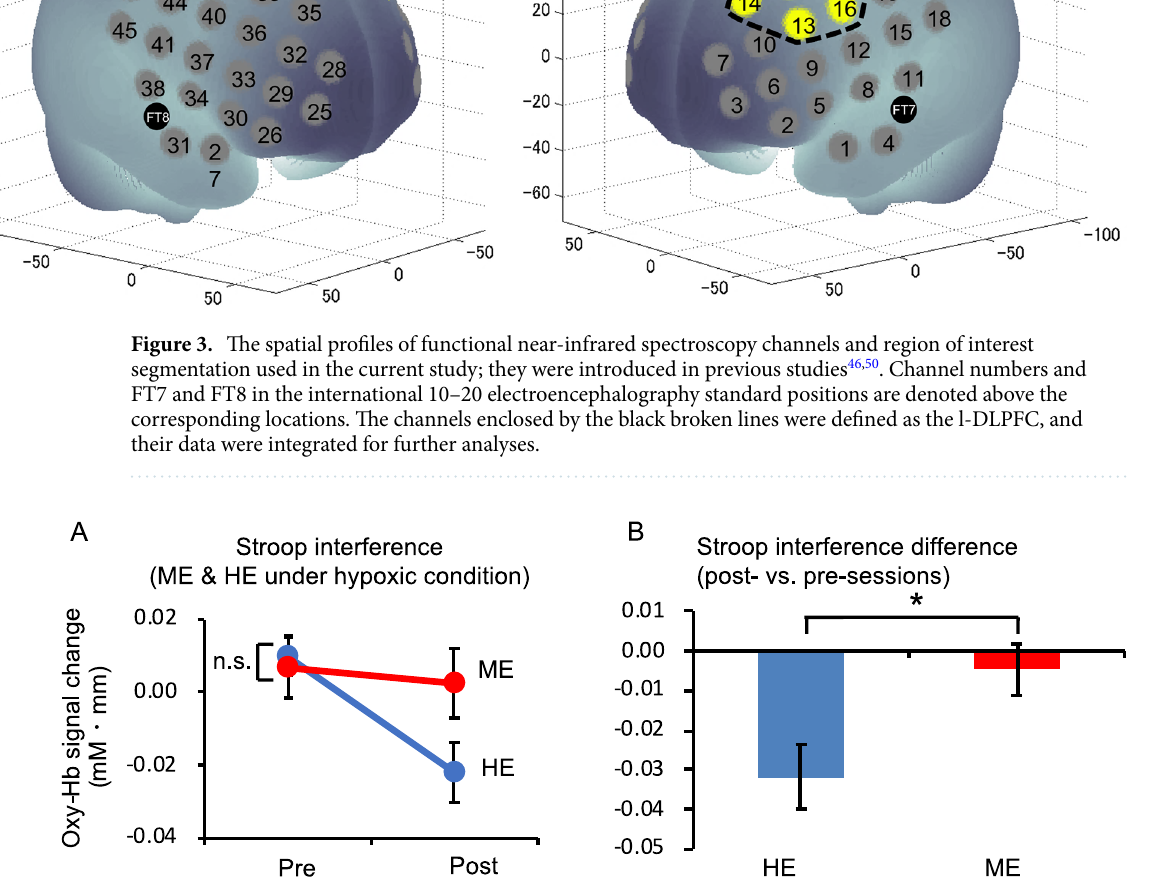
Figure 4. ( A ) Stroop interference differences between post- and pre-sessions for oxygenated hemoglobin (oxy-Hb) signal contrasts in both conditions. ( B ) Oxy-Hb signal differences for the hypoxic exercise (HE) condition are significantly lower than those for the milder hypoxic exercise (ME) condition ( P < 0.05). Error bars indicate the standard